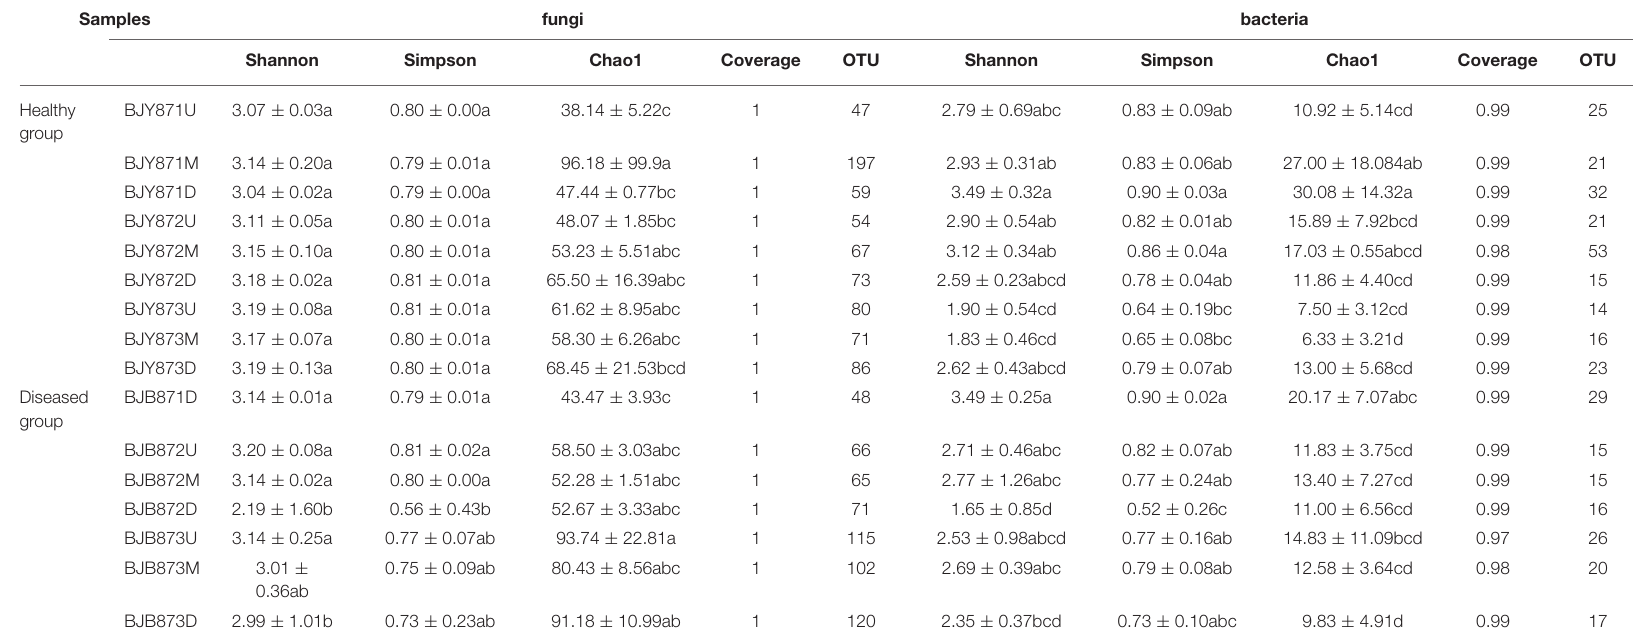
The data in the table are mean ± SD (n = 3). Different lowercase letters in the same column indicate significant differences in treatments at 0.05 level (p <